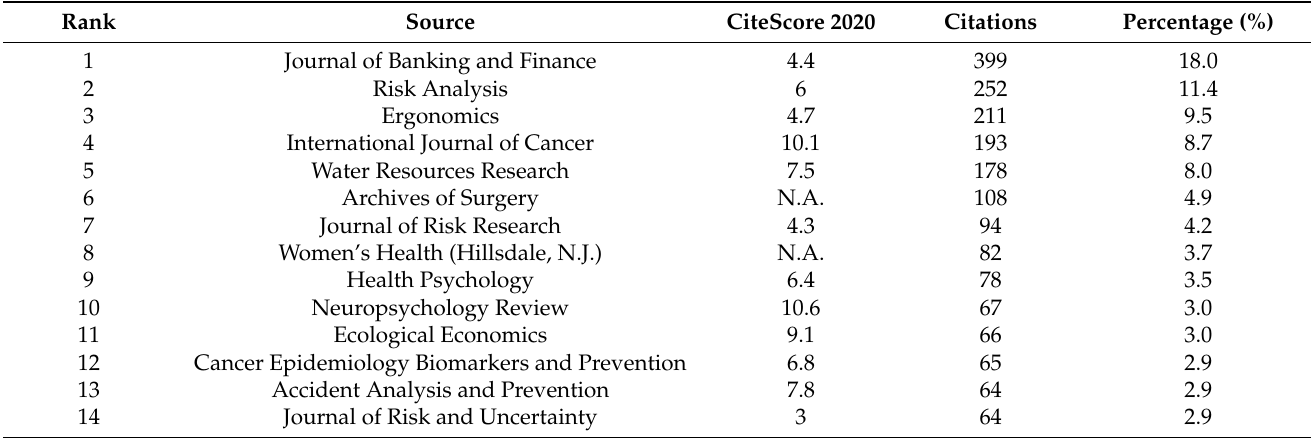
Table 4. Top 20 sources of most cited document on “objective risk” or “subjective